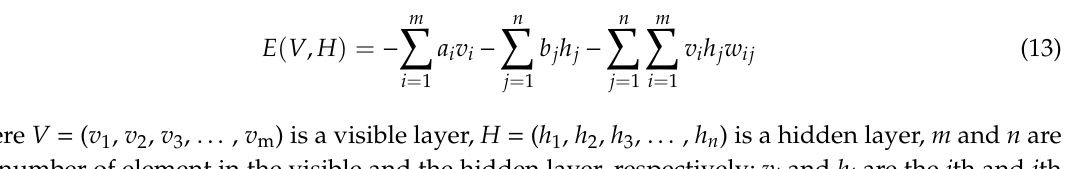
Figure 4. Flowchart of structural load effect prediction based on DBNs.